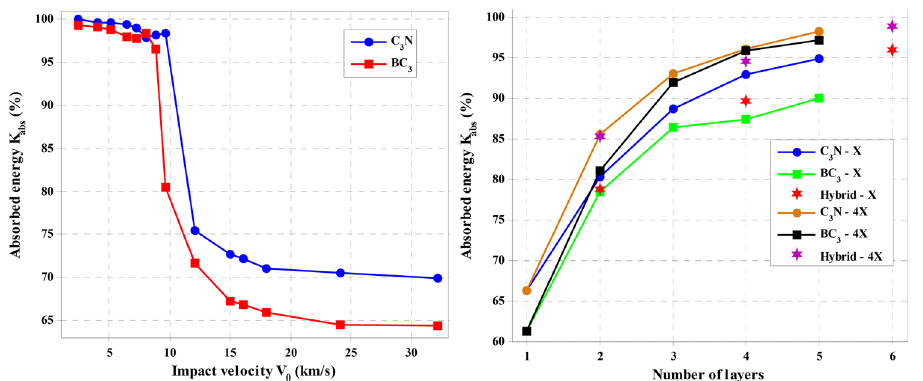
Figure 6. The energy changes adsorbed by the left sheet: increasing impact velocity and right panel: the increasing number of layers for C 3 N, BC 3, and their hybrid